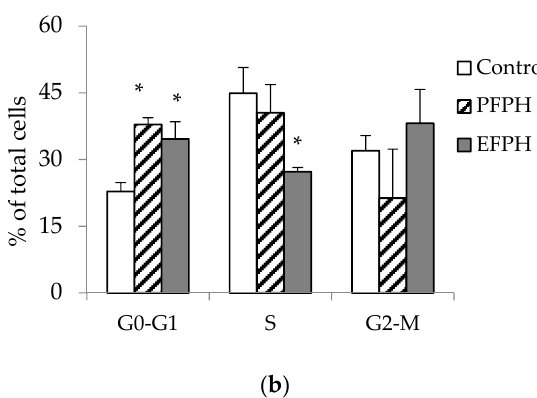
Figure 4. Cell cycle repartition of undifferentiated Caco2/TC7 treated (24 h) or not with fenugreek proteins hydrolysates. ( a ): a representative cells cycle histogram. ( b ): G1, S, and G2 phases percentage distribution. Data are presented as mean ± SD. The experiment was done in duplicate. Superscripted (*) means are significantly different ( p ≤ 0.05) when compared to their respective control. Control: Untreated cells. PFPH: Purafect fenugreek proteins hydrolysate. EFPH: Esperase fenugreek proteins hydrolysate. The hydrolysates were used at a final concentration of 1 mg/mL.